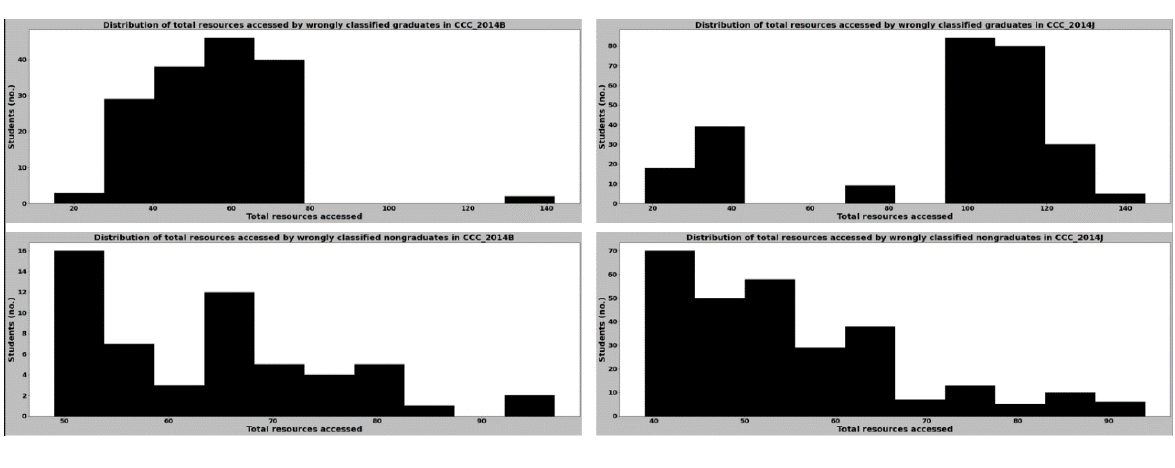
Distribution of the Total Number of Virtual Resources Accessed for Wrongly Classified Learners in Course CCC in 2014